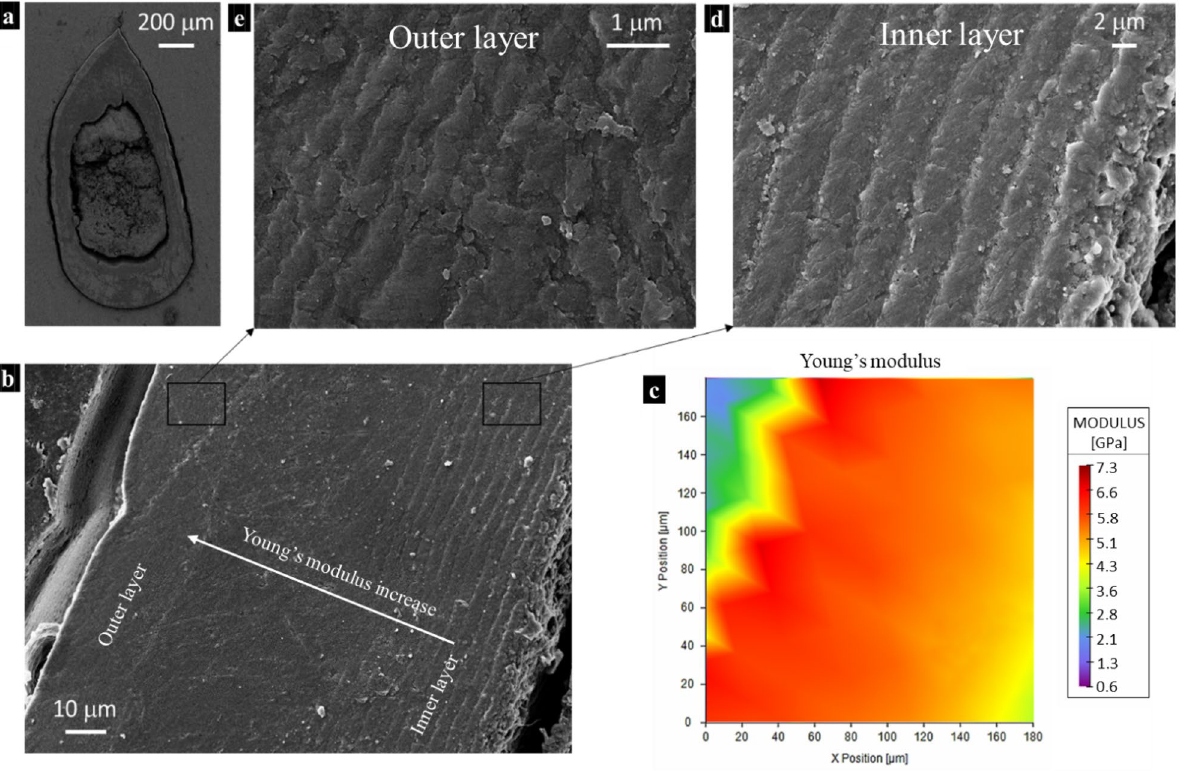
Figure 6. ( a ) Transversal section of the spider fang at its basis by SEM. ( b ) SEM image of the lateral edge of the fang. ( c ) The Young’s modulus map of the region depicted in ( b ) by nanoindentation technique. ( d ) SEM image of the inner cuticle layers of the fang. ( e ) SEM image of the outer cuticle layer of the fang. Images generated with the support of Nanoblitz 3d, Nanomechanics